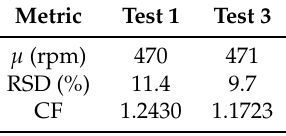
Table 2. Mean, RSD and CF of the rotor speed time series: test 1 and test 3.